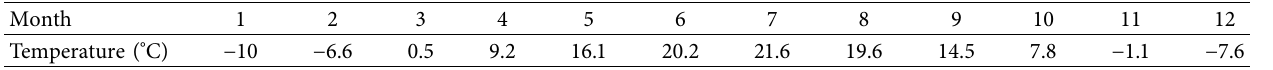
Table 4: The local monthly mean temperature.